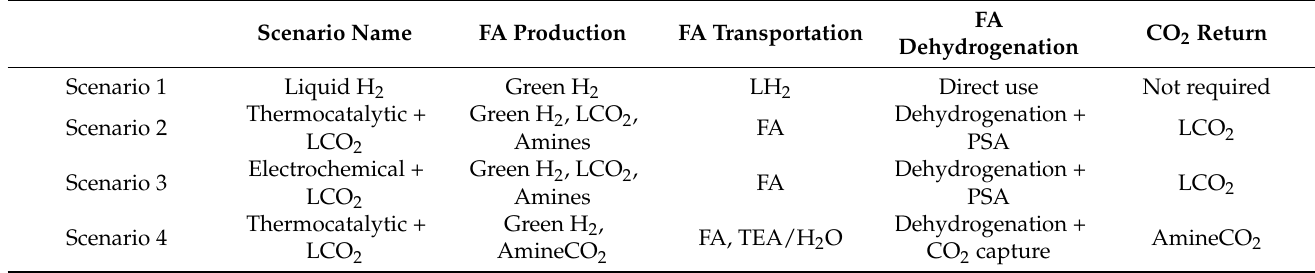
Table 2. Details of the analyzed H 2 supply scenarios.